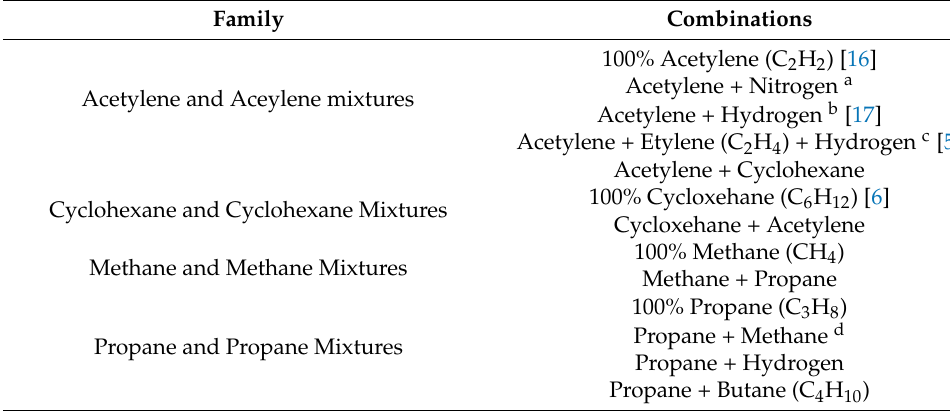
Table 1. Carboniferous gases and mixtures used in low-pressure carburising (LPC) [10,15]. Family Combinations